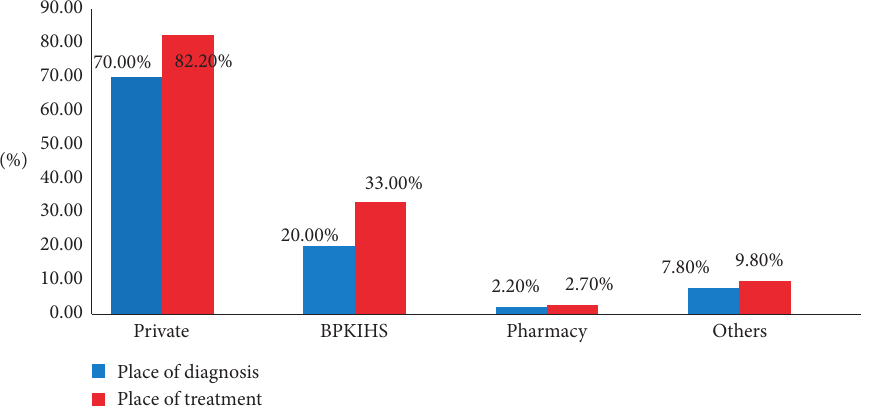
Figure 2: Distribution of participants according to place of diagnosis and treatment; multiple response was provided by the participants for visiting different health care facilities for diagnosis and